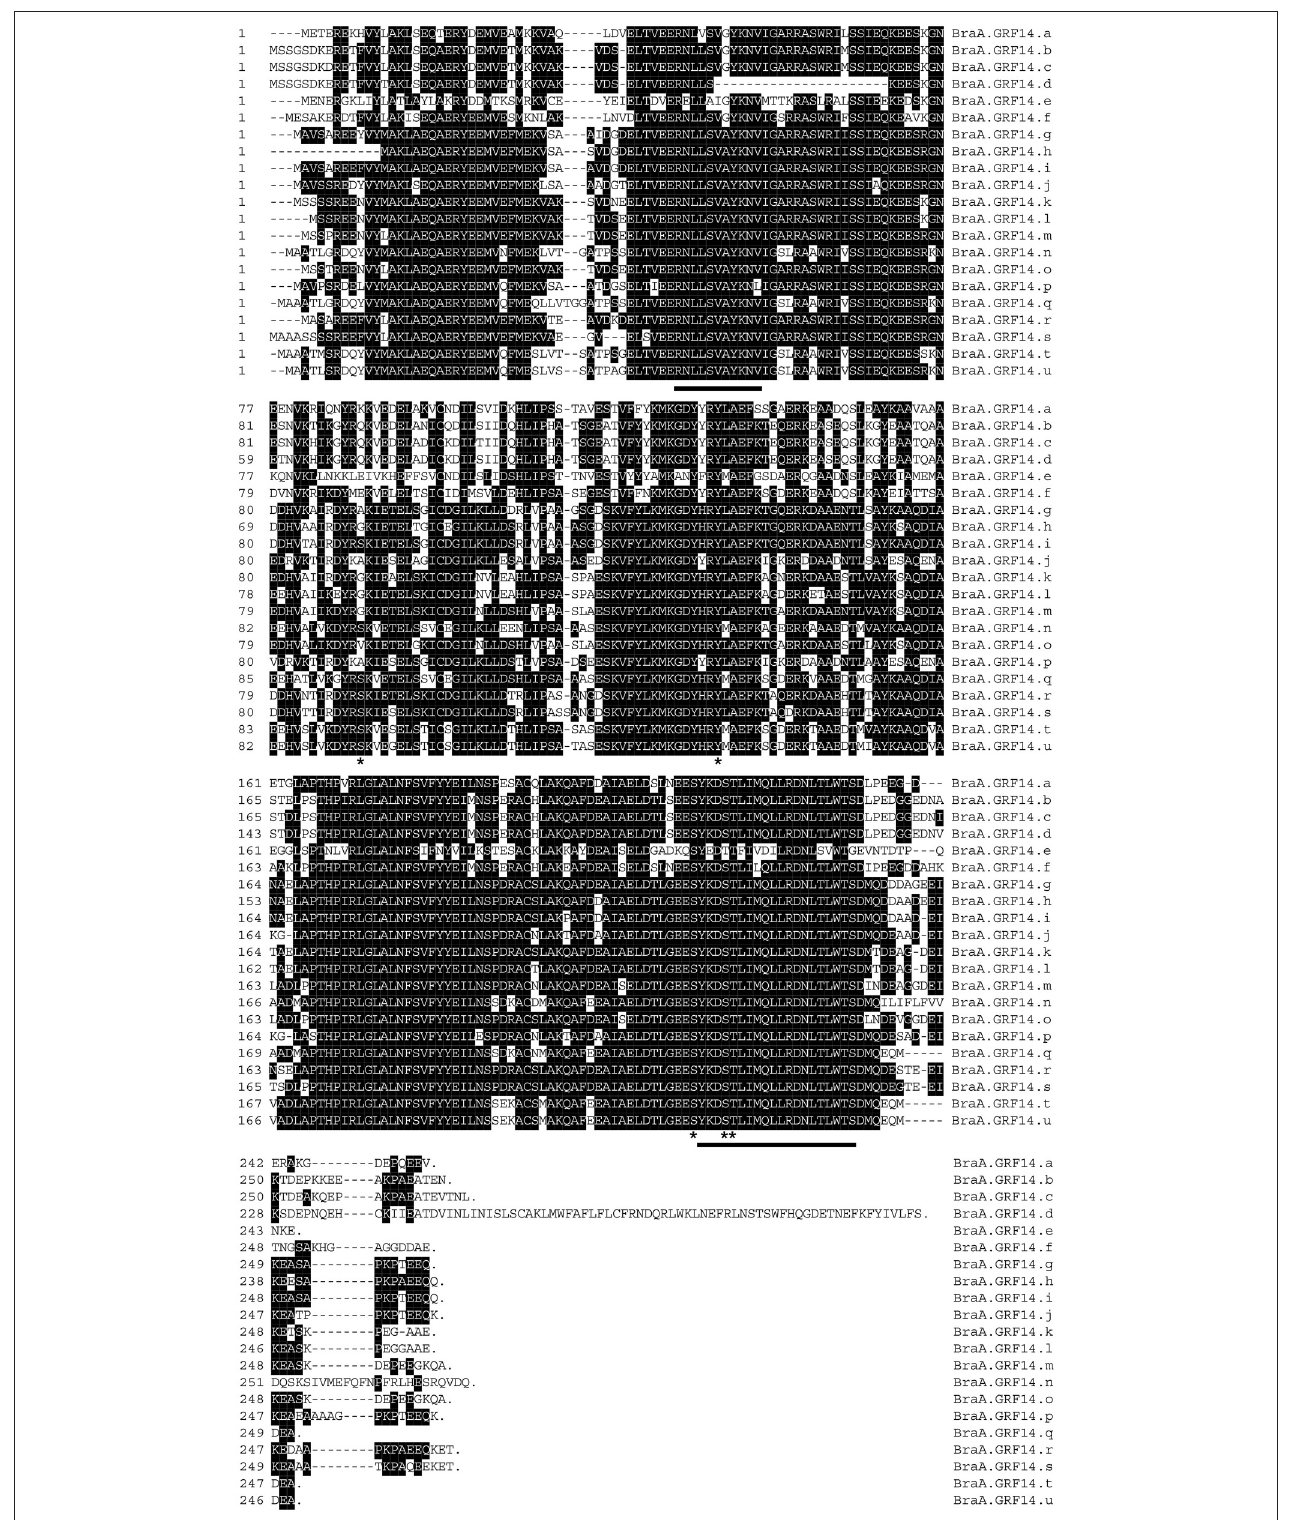
FIGURE 1 | Amino acid alignment of the deduced 14-3-3 proteins of B. rapa (BraA.GRF14). The sequence alignment of the 21 BraA.GRF14 proteins was performed using ClustalW. The 14-3-3 signature motifs RNL(L/V)SV(G/A)YKNV and YKDSTLIMQLLRDNLTLWTS, are underlined. The phosphorylation sites reported earlier for plant 14-3-3 proteins (Paul et al., 2012) are marked with asterisk.